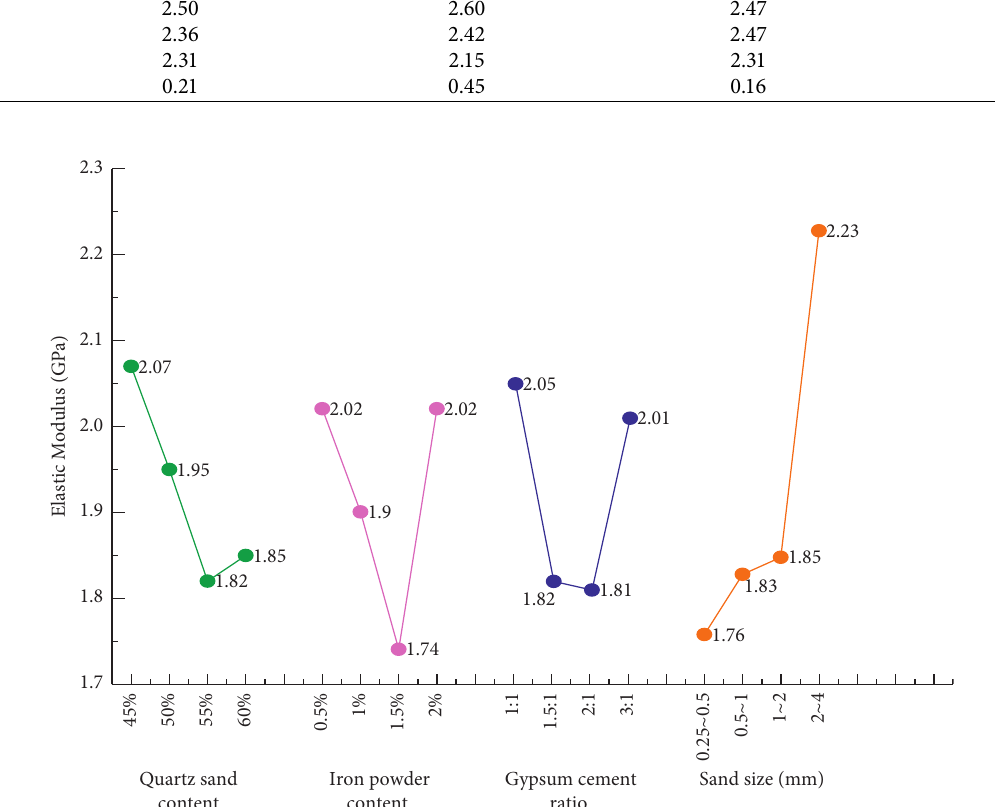
Figure 9: Influence of various factors on the elastic modulus of similar materials covered by the